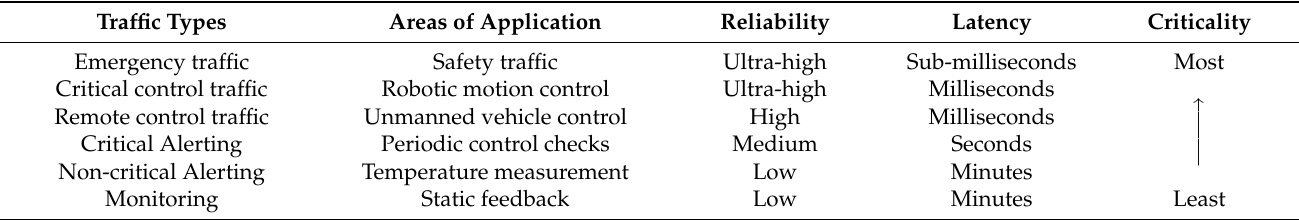
Table 4. Latency and reliability summary for industrial communication